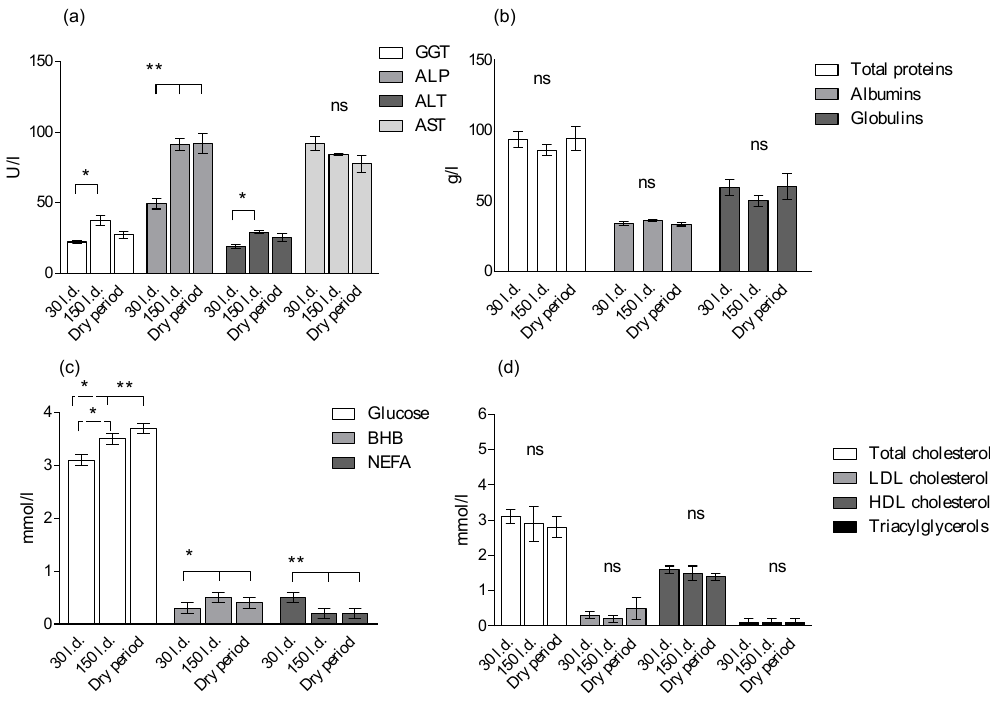
Figure 3. Serum biochemical parameters in Holstein cows during the production period: (a) activities of gamma-glutamyltransferase (GGT), aspartate aminotransferase (AST), alanine aminotransferase (ALT), and alkaline phosphatase (ALP); (b) concentrations of total proteins, albumins and globulins; (c) concentrations of glucose, beta-hydroxybutyric acid (BHB) and non-esterified fatty acids (NEFAs); (d) con- centrations of total, low-density lipoprotein (LDL) and high-density lipoprotein (HDL) cholesterol, and triacylglycerols. l.d.: lactation day; ns: non-significant; ∗ significant difference between sampling periods at P < 0 . 05; ∗∗ significant difference between sampling periods at P < 0 .